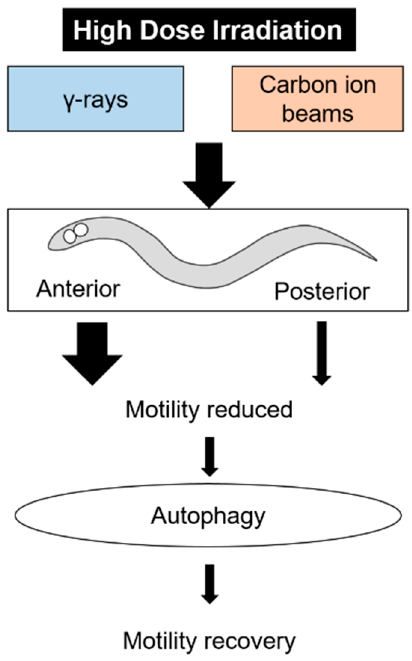
Figure 9. The summary of this study on effects of high-dose irradiation.